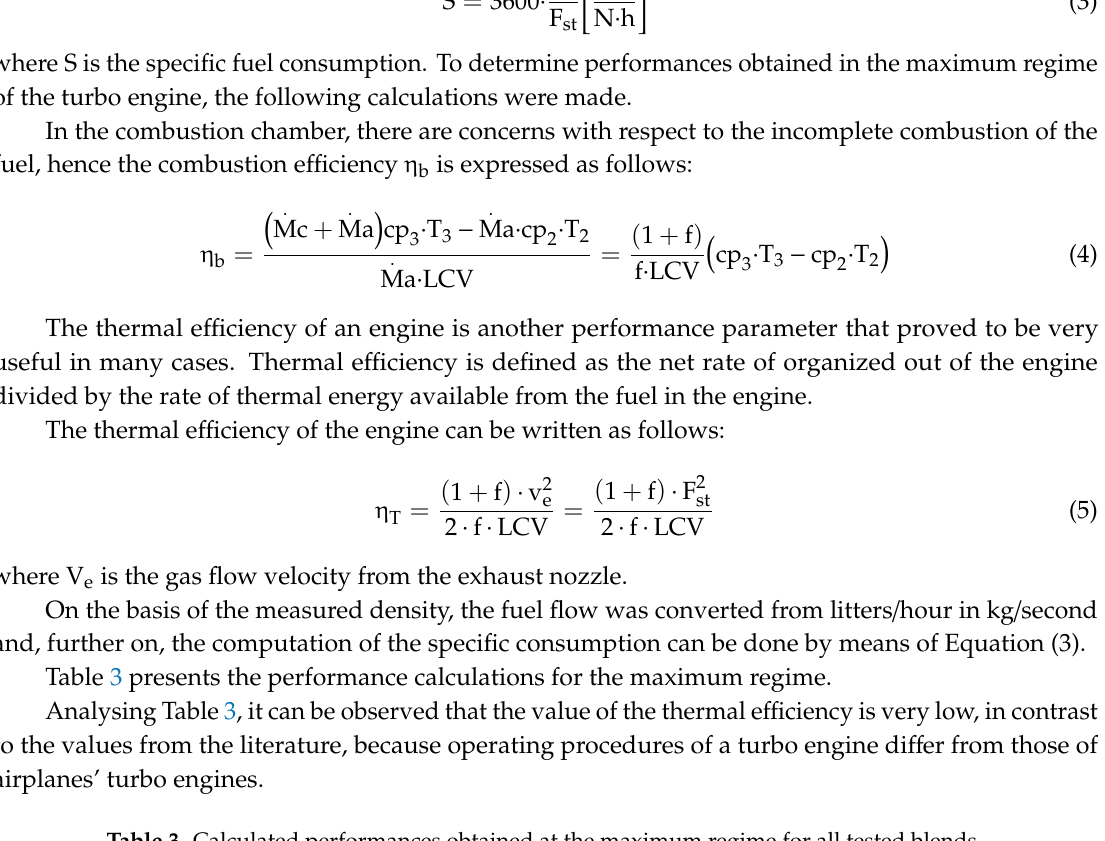
Table 3. Calculated performances obtained at the maximum regime for all tested